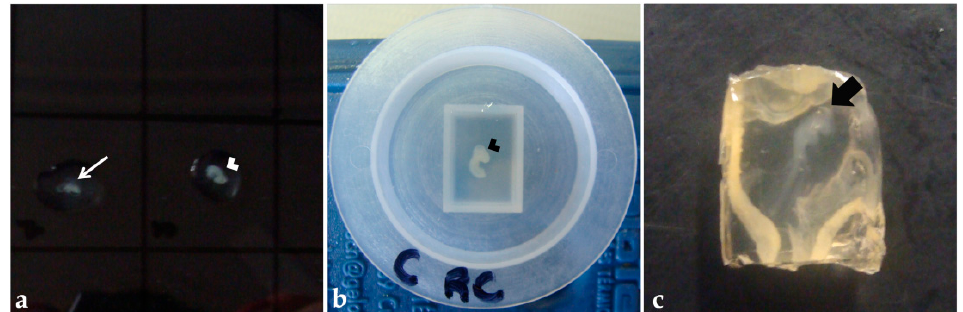
Figure 4. Pre-embedding in agar–gelatin solution: ( a ) Embryo fragments into a drop of solution on a Petri dish. ( b ) Cephalic and cervical regions of an embryo in a polyethylene mold filled with the solution. ( c ) Agar–gelatin block after polymerization. Thinner arrow: Trunk-caudal region. Arrowhead: Cephalic and cervical region. Thicker arrow: Embryo.